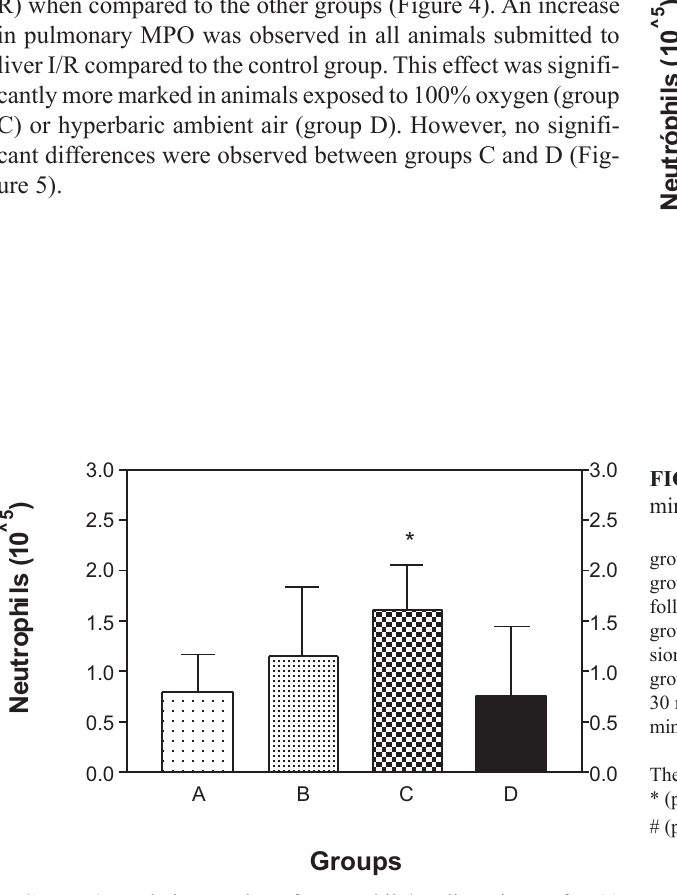
FIGURE 4 – Relative number of neutrophils/mg liver tissue after 30 min of segmental liver ischemia and 30 min of reperfusion group A (n=8, control): laparotomy and manipulation of the liver pedicle; group B (n=8): laparotomy and 30 min occlusion of the vascular liver pedicle, followed by reperfusion for 30 min; group C (n=8): HO therapy at 2.5 ATA for 60 min, laparotomy, 30 min occlu- sion of the vascular liver pedicle, followed by reperfusion for 30 min; group D (n=8): exposure to ambient air at 2.5 ATA for 60 min, laparotomy, and 30 min occlusion of the vascular liver pedicle, followed by reperfusion for 30 min. The columns represent the mean ± standard deviation. *(p < 0.05) compared to groups A, B and D.